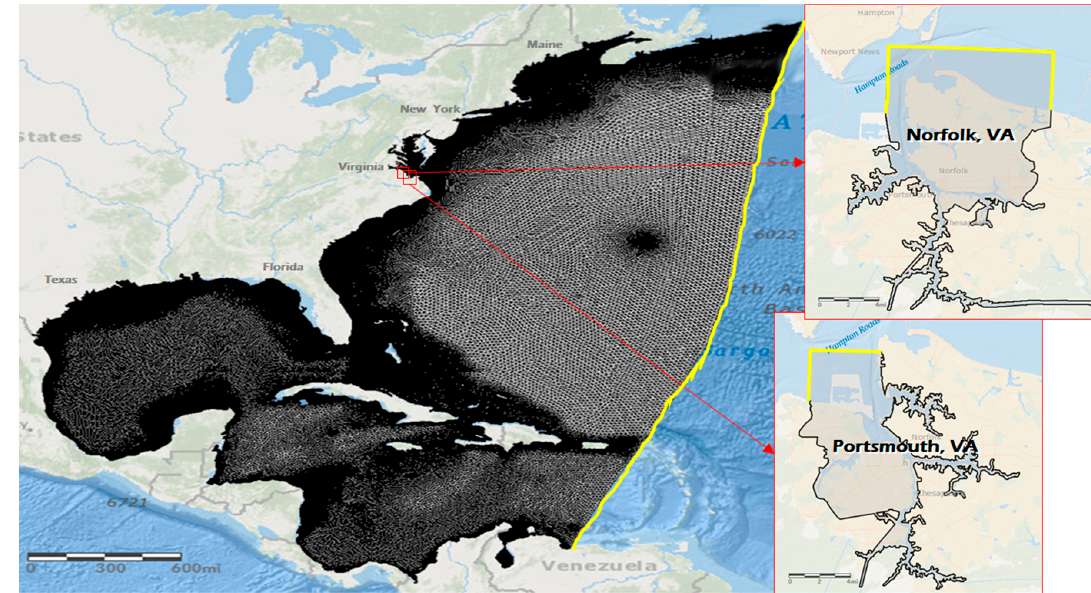
Figure 1. The SCHISM Hydrodynamic model grid used to drive the Tidewatch storm tide prediction model, and inset at right, are some example city-scale sub-grid model sub-basins for Norfolk (top) and Portsmouth (bottom) driven by SCHISM using Dirichlet boundary conditions.